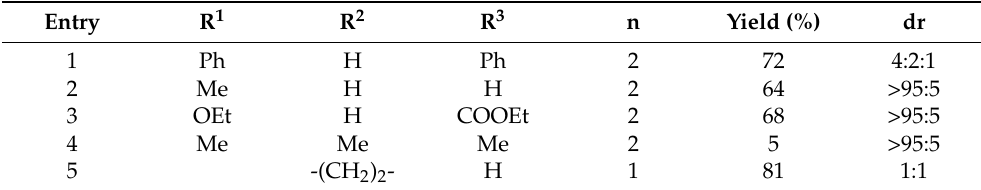
Aggarwal and co-workers also studied carbene-based stabilized ylides generated from an enantiomer of chiral sulfide 5 ( ent -5 ) in the cyclopropanation of cyclic α , β -unsaturated ketones. Fused bicyclic cyclopropanes were formed with high enantioselectivity, but without any observed diastereoselectivity (Scheme 37) [93]. However, the equivalent reaction using the stoichiometric sulfonium salt deprotonation method of generating the ylide was shown to provide high diastereoselectivity but low enantioselectivity for one of